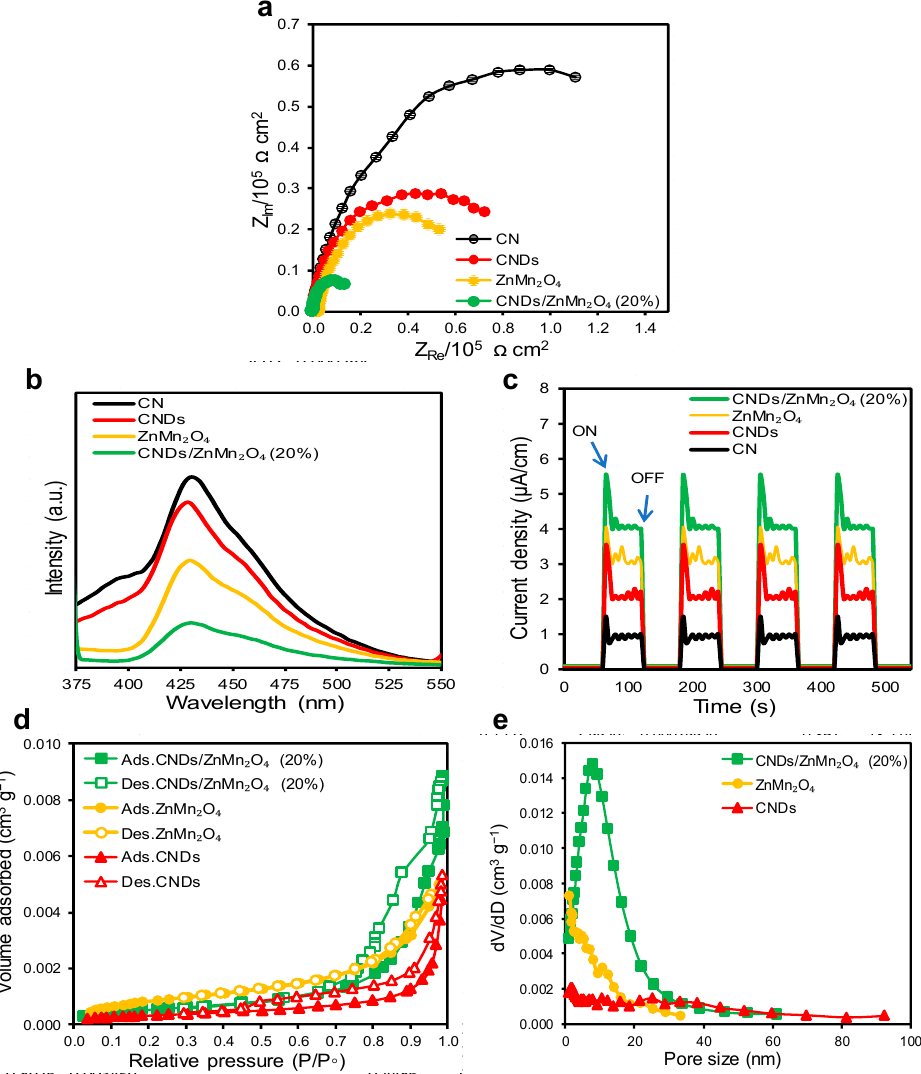
Figure 5. ( a ) EIS, ( b ) PL, and ( c ) Photocurrent of CN, CNDs, ZnMn 2 O 4 , and CNDs/ZnMn 2 O 4 (20%) photocatalysts. ( d ) N 2 sorption data and ( e ) pore-size distributions for CNDs, ZnMn 2 O 4 , and CNQDs/ZnMn 2 O 4 (20%) photocatalysts.